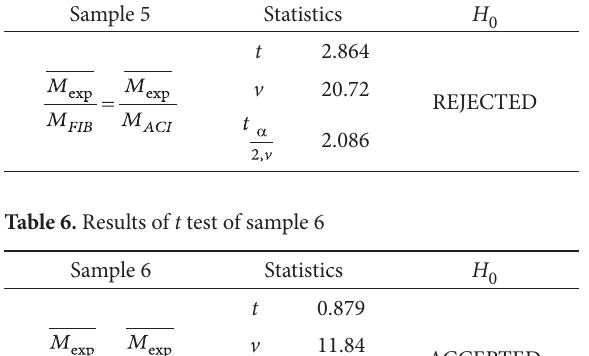
Table 5. Results of t test of sample 5 Sample 5